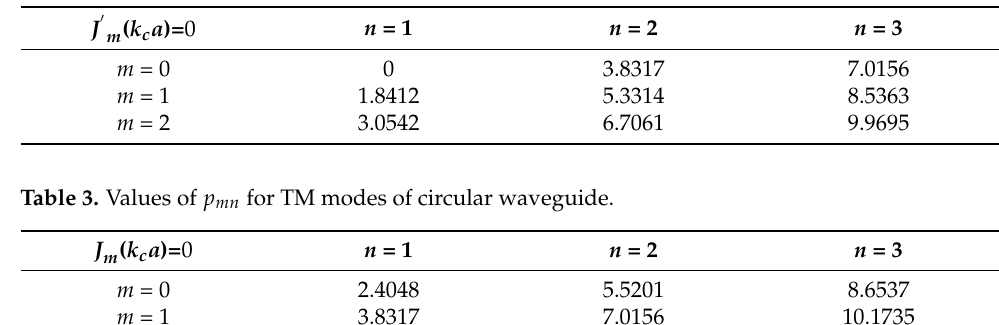
Table 2. Values of (cid:1868)′ (cid:3040)(cid:3041) for TE modes of circular waveguide . Table 2. Values of p (cid:48) mn for TE modes of circular waveguide. (cid:2166)′ (cid:4666)(cid:2193) (cid:2183)(cid:4667) (cid:3404) (cid:2777) (cid:2195) (cid:2185)